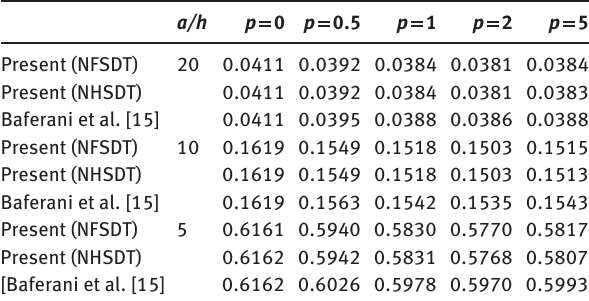
Table 3: Comparison study of the nondimensional fundamental ω ′ of simply supported FG plates ( a / b = 1, frequency parameter 1 = K = 100). K w s